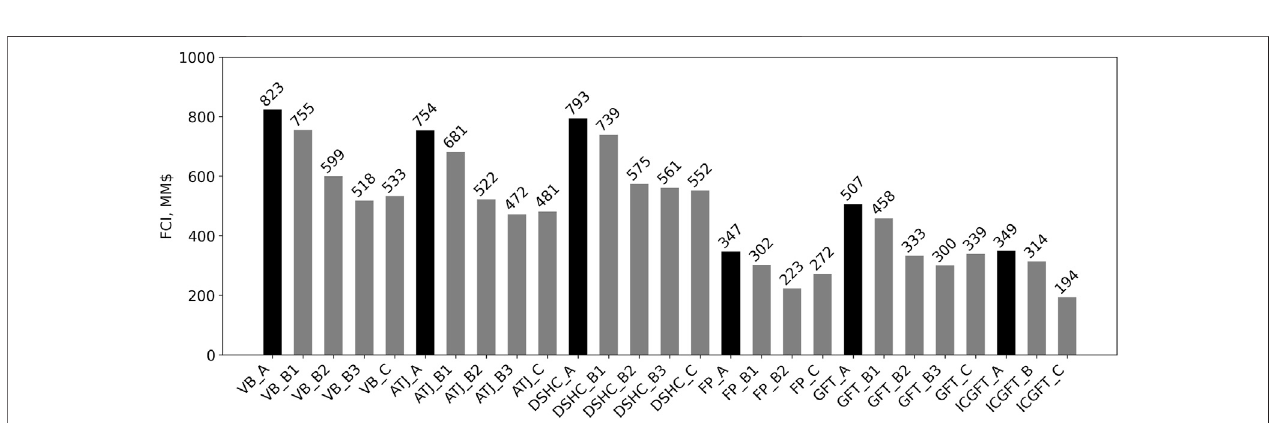
FIGURE 4 | FCI reductions of integrated scenarios (grey), in comparison with their respective standalone scenarios (black).